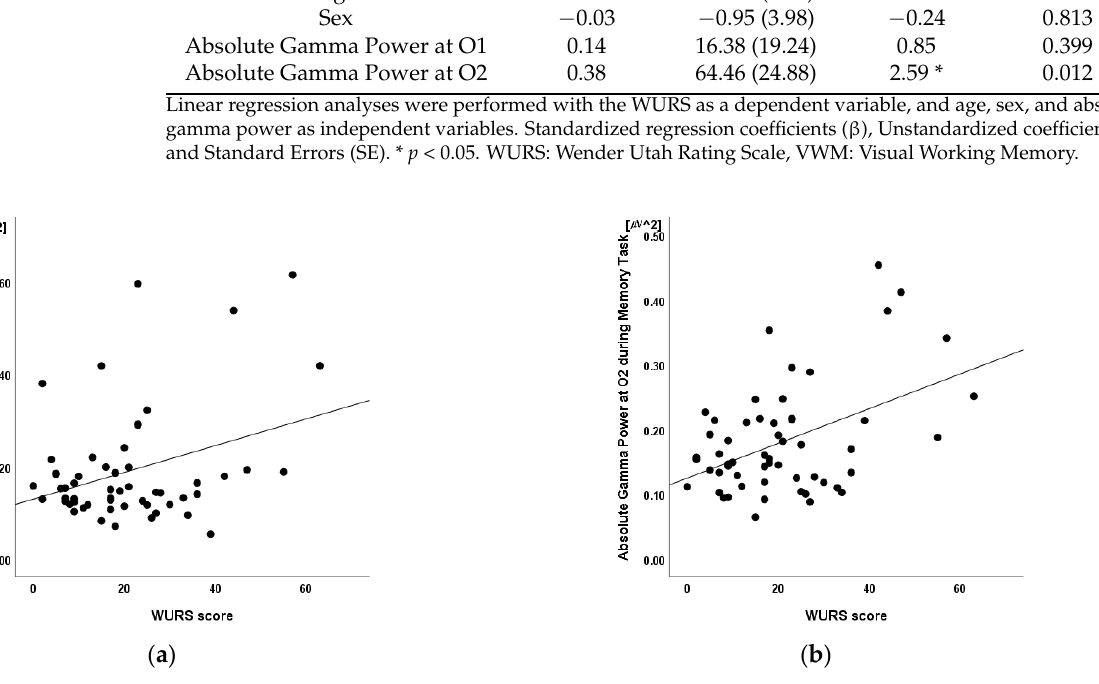
Figure 6. Relationship between the Wender Utah Rating Scale scores and the absolute gamma power at electrodes ( a ) O1 and ( b ) O2 during the retention interval period of the visual working memory task (n = 56, R 2 =0.23, p = 0.399 and p = 0.012, respectively). Mean absolute power in µ V 2 . WURS: Wender Utah Rating